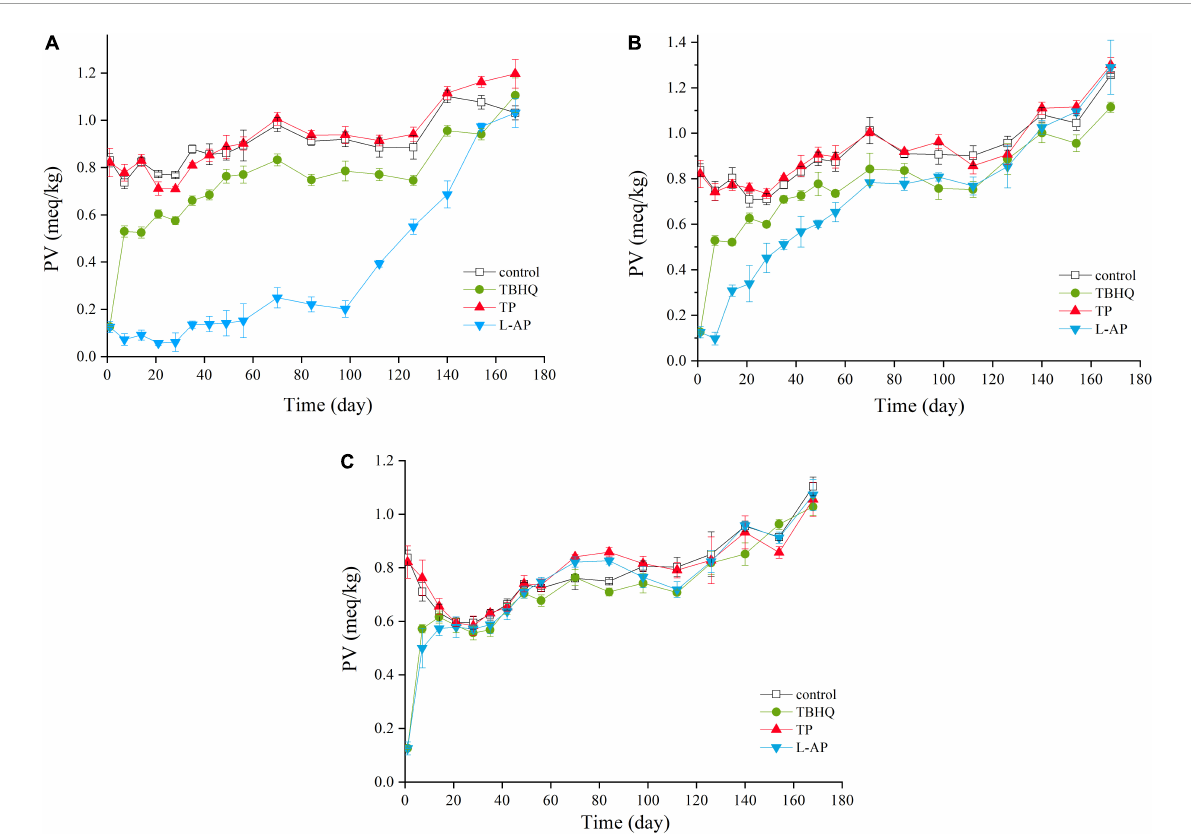
FIGURE1 PV values of HPBF with the addition of TBHQ, TP, and L-AP during the storage display at different temperature [ (A) 4 ◦ C; (B) 20 ◦ C; (C) 50 ◦ C]. The color discrimination is to distinguish four groups including control test, TBHQ, TP, and